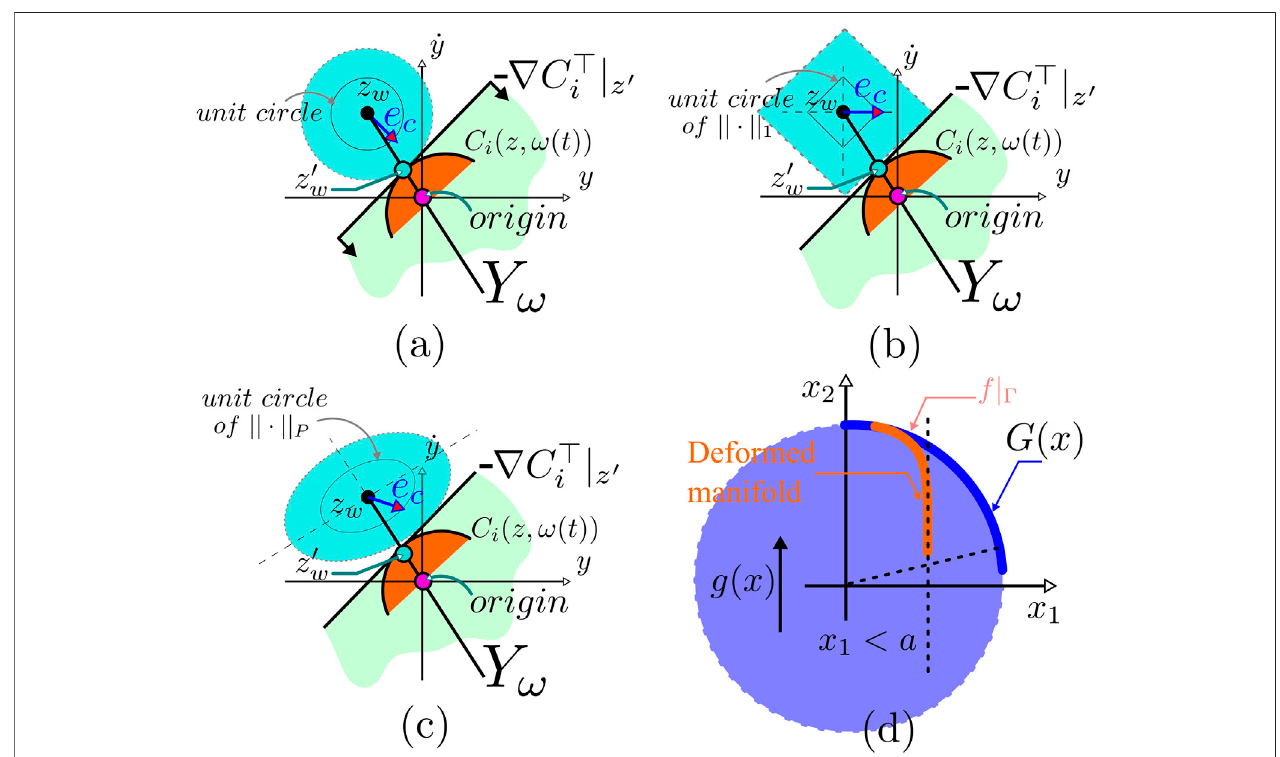
FIGURE 6 | (A – C) Illustration of constraint satisfaction based on manifold deformation; Also, it shows the concept with various norm de fi nitions. (D) Illustration of the relationship between the stabilizability of the manifold Γ (unit circle is used as an example) and the transversality condition, i.e., z G z algebraic equation that de fi nes Γ and g ( x ) is the control vector fi eld used to stabilize the trajectories on Γ .